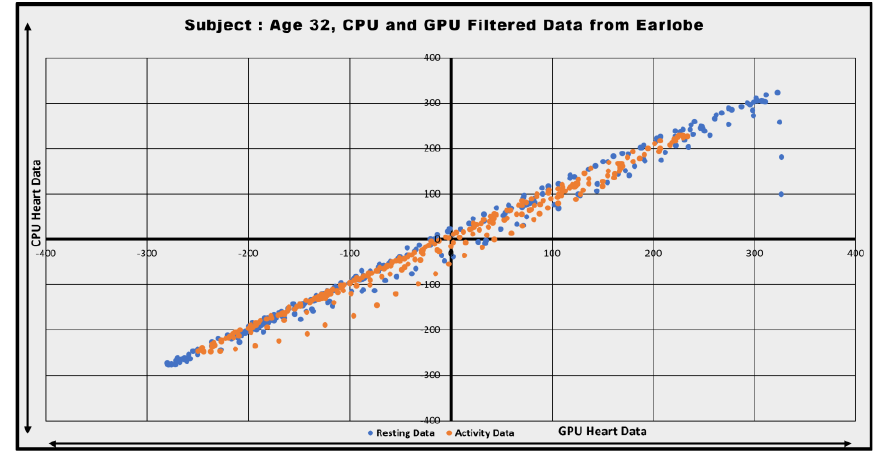
Figure 22. Normal Sinus Rhythm representation for CPU and GPU. Figure 22 represents the normal sinus rhythm occurrences computed both for a CPU and GPU and the data seems to be evenly spread from left ventricular to right ventricular region. While resting and performing some activity, the heart rate increase can be ob- served in orange color, showing increased heart rate. Similarly in Figure 23, the normal rhythm in blue and ventricular data in orange are observed. The ventricular data are widely spread with no rhythm. Meanwhile, the signal is rapidly moving around the left and right ventricular region, which clearly shows signs of critical heart conditions.